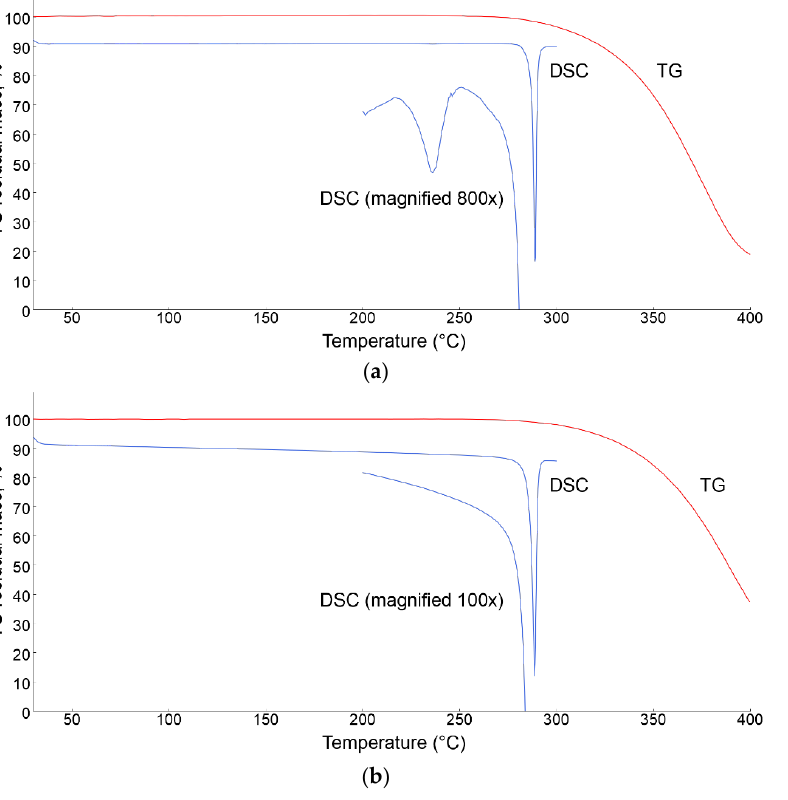
Figure 6. Thermodiffractometric (TG, in red) and calorimetric (DSC, in blue) curves for Tafamidis Form 1 ( a ) and Tafamidis Form 4 ( b ). The magnification of the DSC trace of panel ( a ) shows a broad endothermic event peaking near 240 °C, related to the Form 1 to Form 4 transformation. This peak is absent in Form 4, while melting of Form 4 (onset at ca. 283 °C) is observed in both samples.